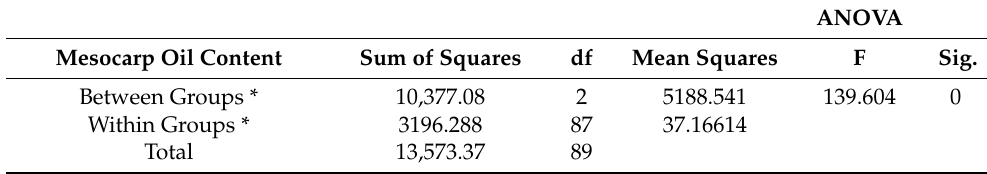
Table 2. ANOVA results for mesocarp oil content data.